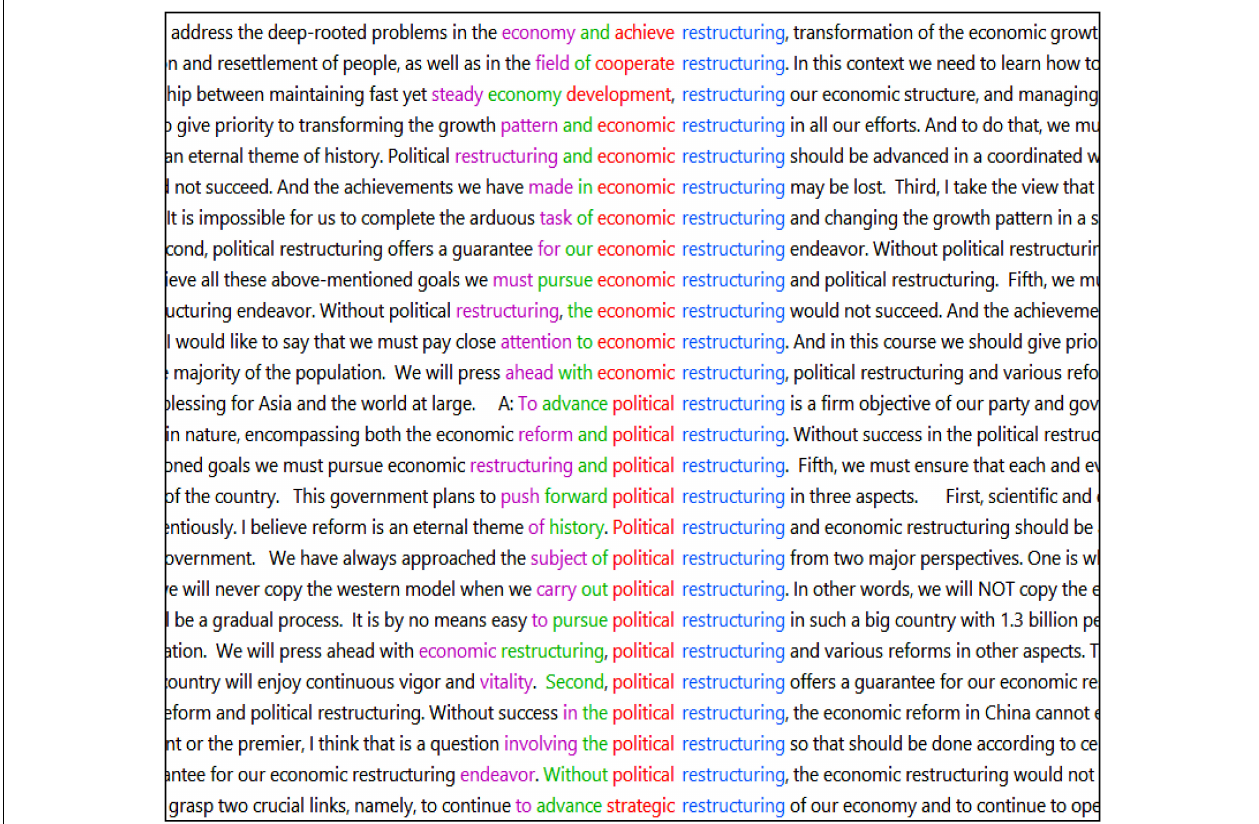
FIGURE 3 | Screenshot of concordance lines featuring economic/political restructuring (sorted to the